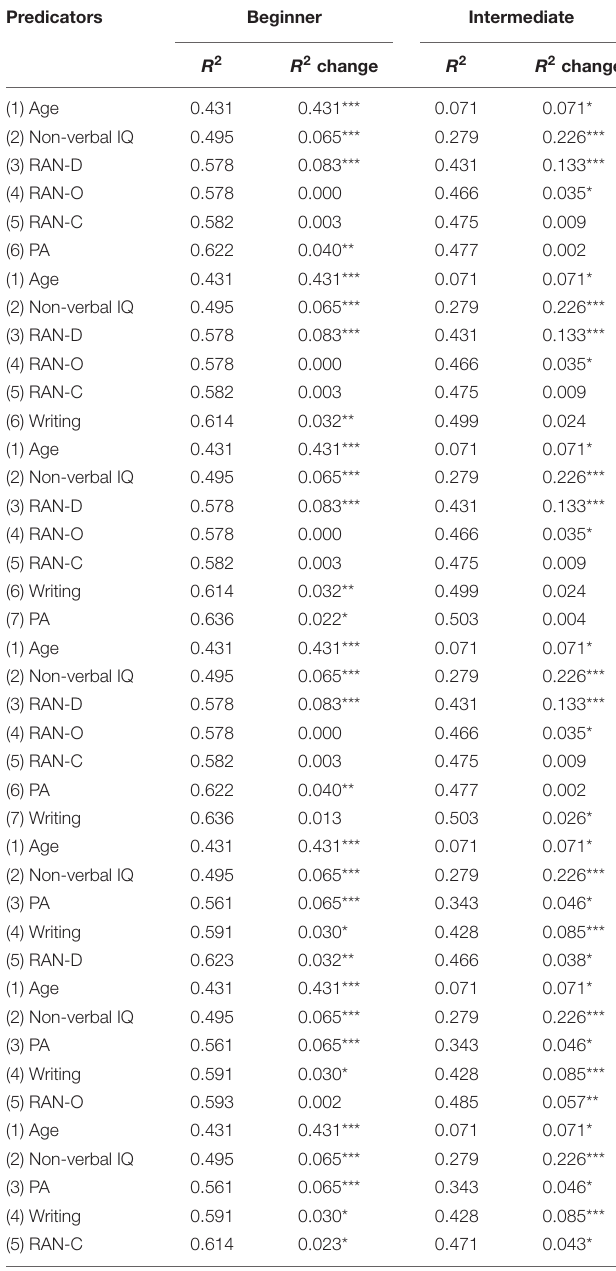
TABLE 3-2 | Summary of hierarchical multiple regressions that tested the predictive power of various component skill measures for reading fluency. Reading fluency ( (cid:49) R 2 )